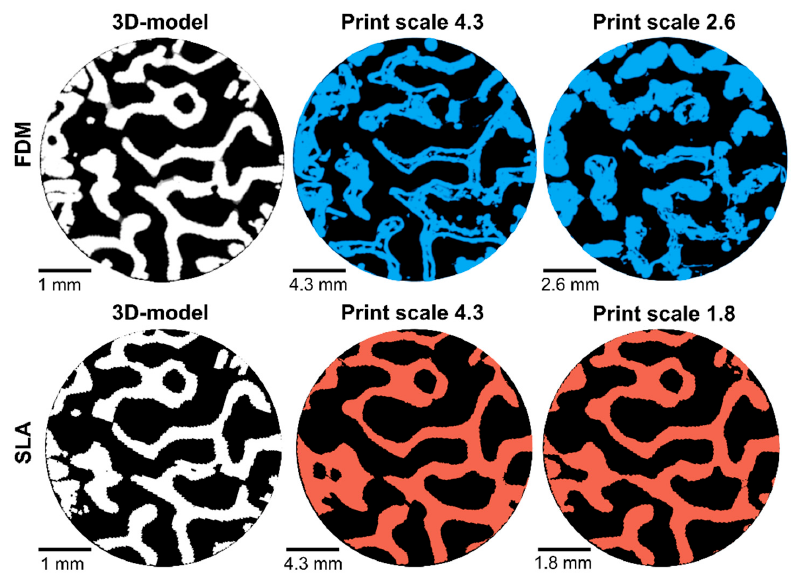
Figure 7. Cross-sectional comparison of registered micro-CT images, of the same part of the 3D- model, from the model and the printed parts produced by FDM ( upper row ) and SLA ( lower row ). Cross-sections for the 3D-models are displayed in white, and the printed parts in blue (FDM) or red (SLA). The images in the upper row are adapted with modifications from [13].